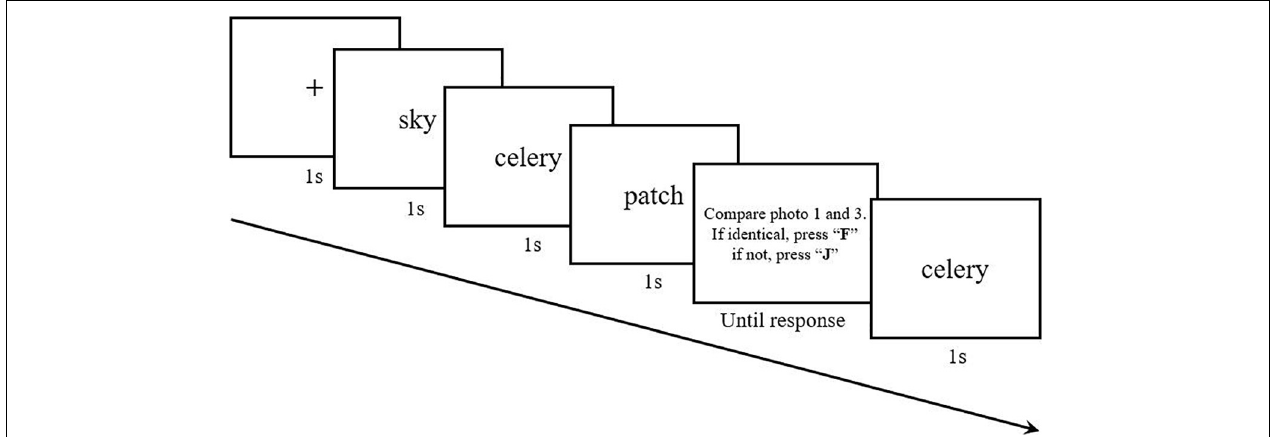
FIGURE 6 | Each trial contained five words and participants needed to compare the current word and the one appearing before the previous word. This meant they needed to start comparison from the third word. Once the third word disappeared, the judging phase started and participants had to press the keyboard to indicate their judgment. There was no feedback. After judging, the fourth word appeared.